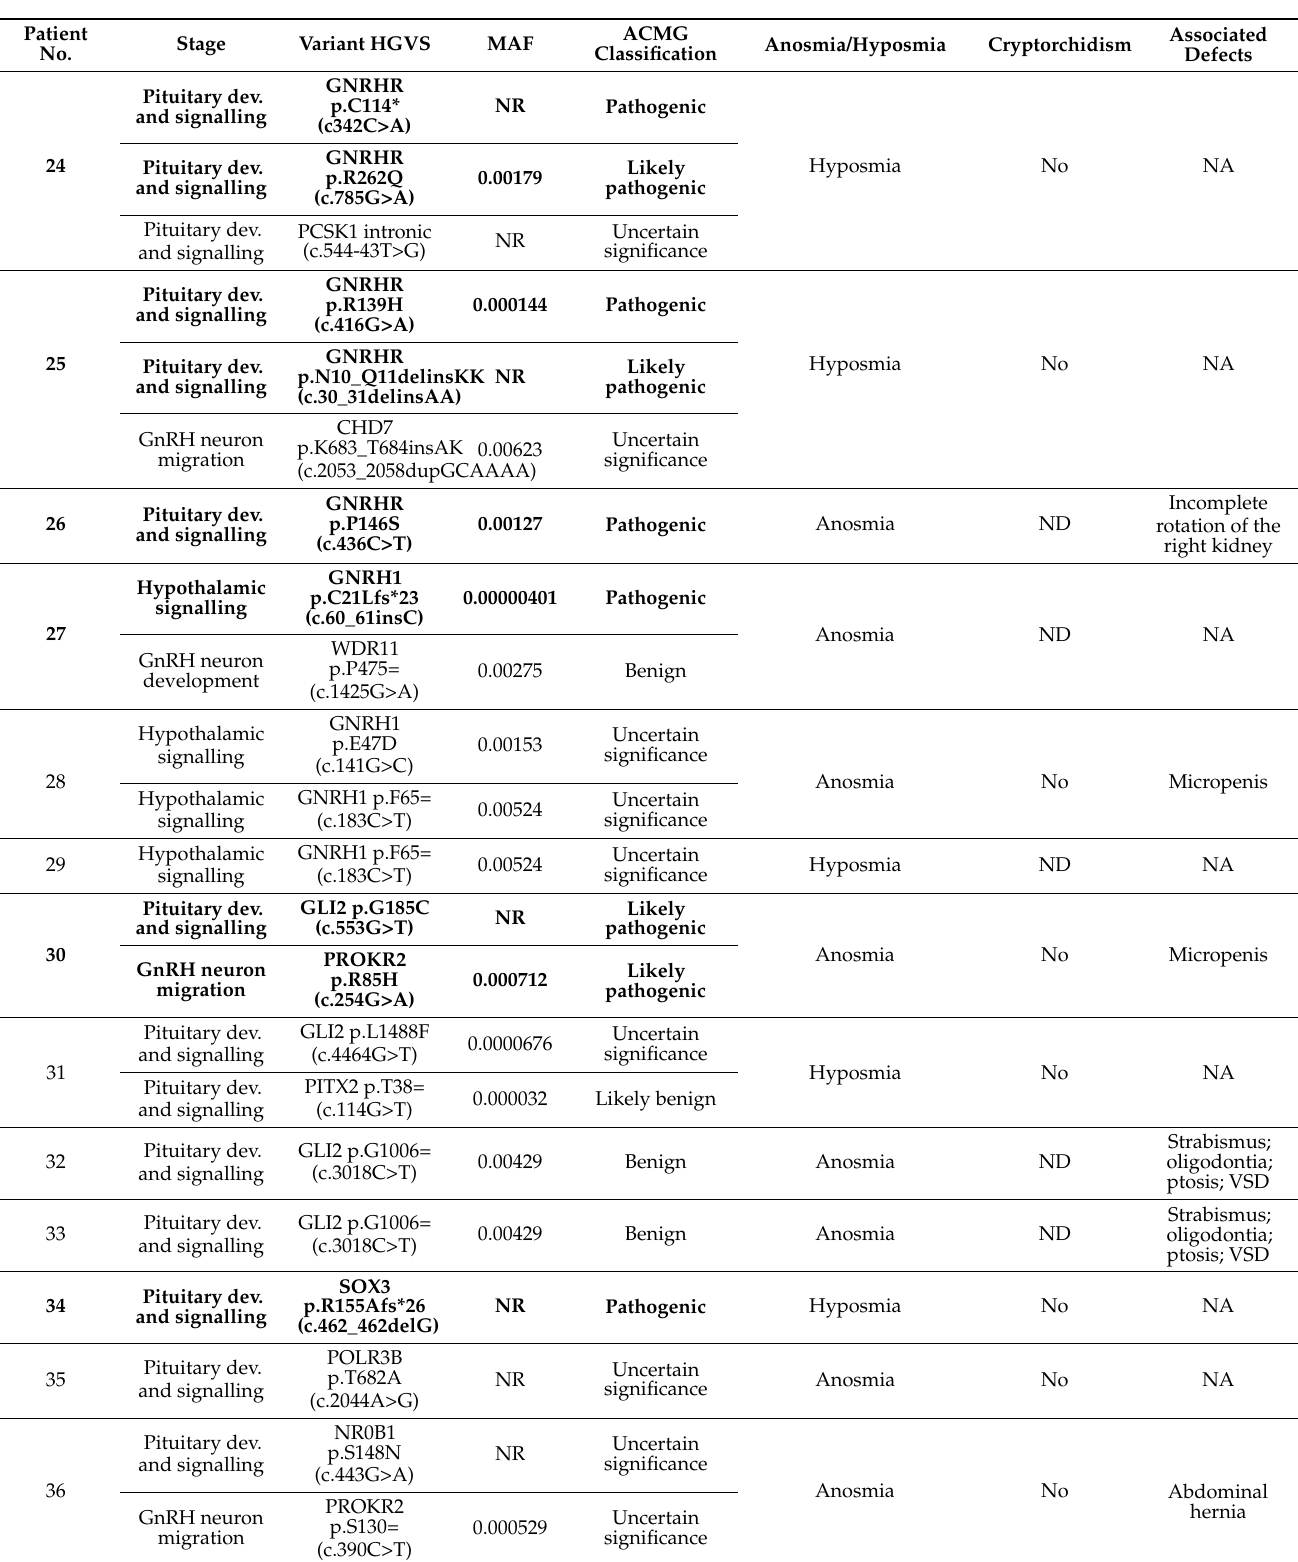
Table 2. KS patients with genetic defects in hypothalamic/pituitary development and signaling. Patient